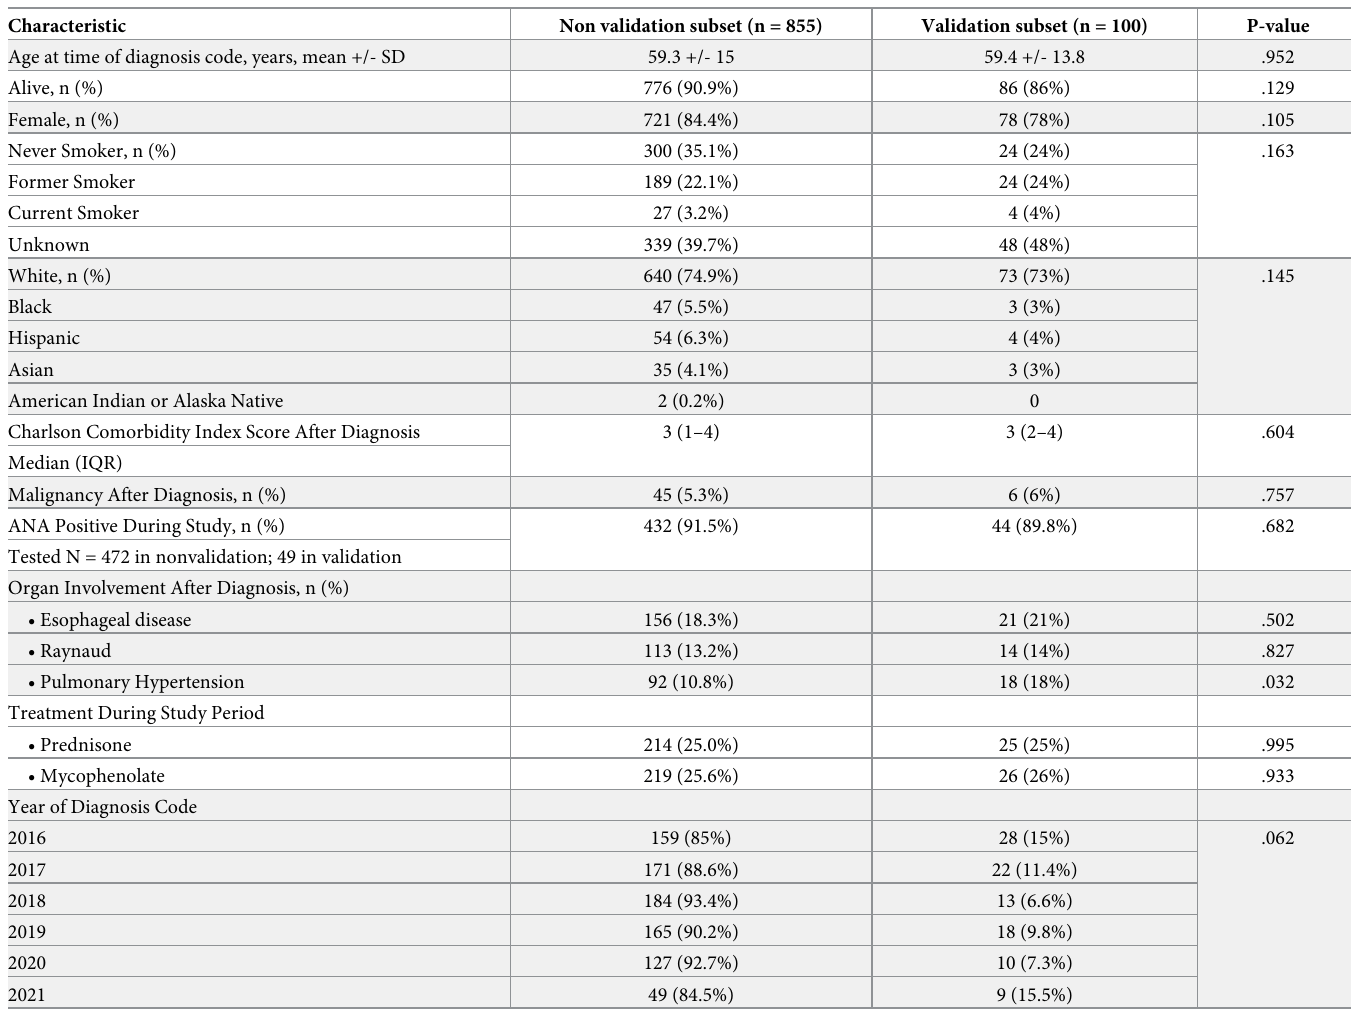
Table 1. Characteristics of entire cohort by randomization for baseline code validation subset n =